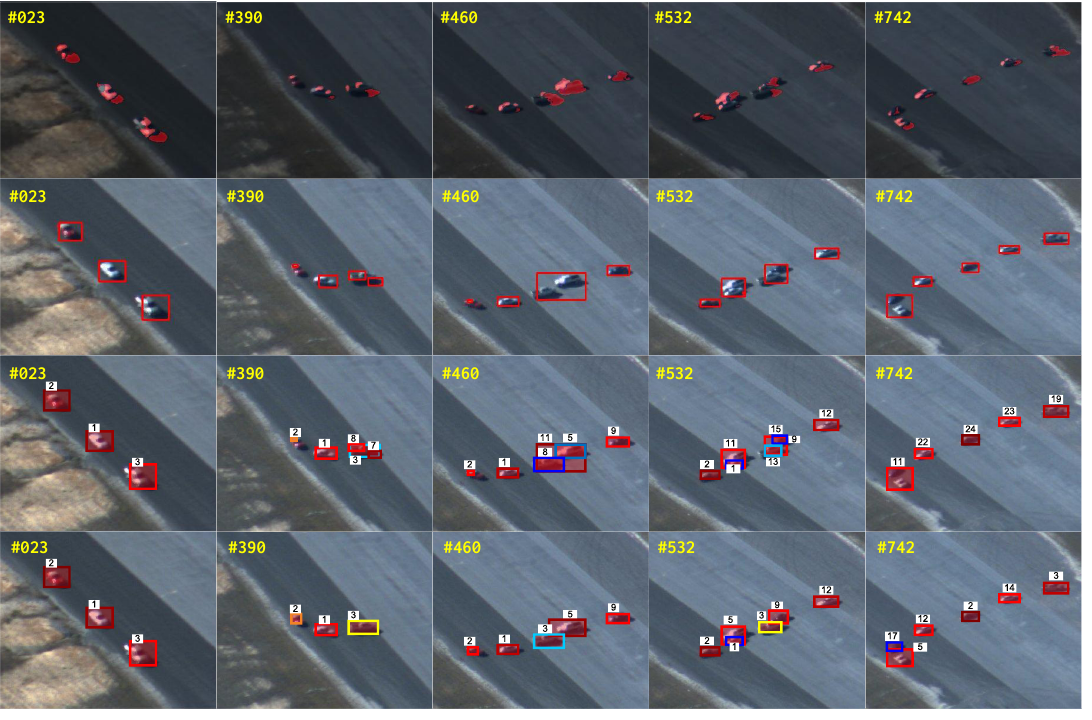
Figure 8. Detection and tracking results. First row: the detection results. Second row: the bounding box for each detection. Third row: the tracking results using the framework S 1 . Fourth row: the tracking results using the framework S 2